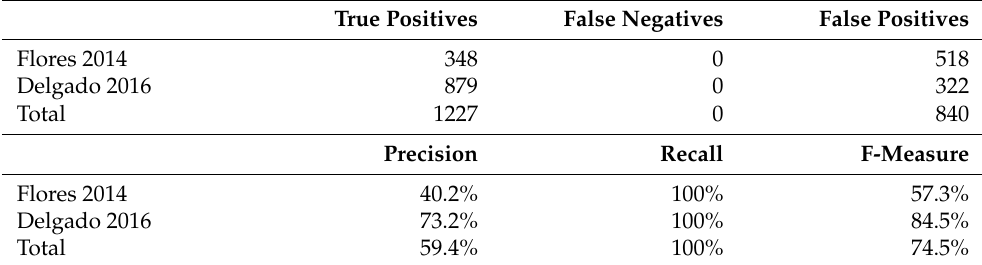
Table 4. Precision and recall for ontological predicates computed on two papers. True Positives False Negatives